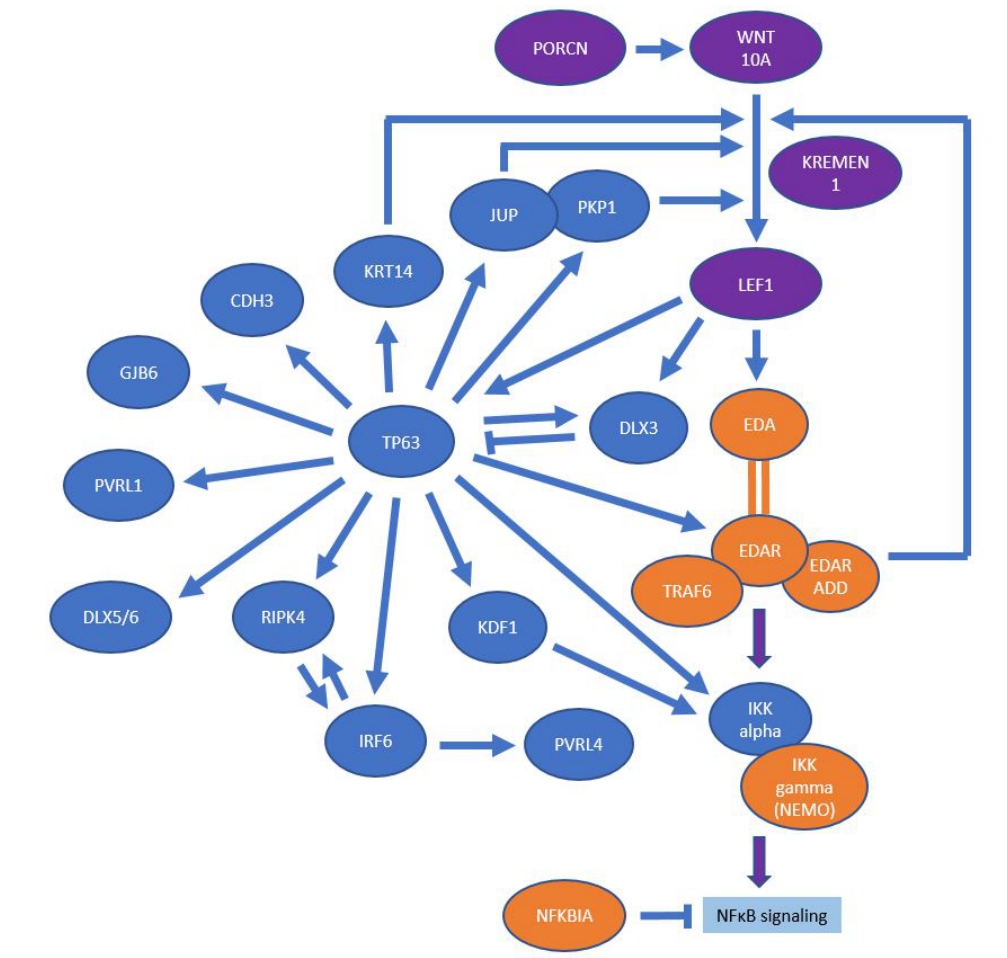
Figure 2. The multiple interactions between the EDA/NF- κ B, Wnt and p63 pathways (in orange, pur- ple, and blue, respectively). Arrows indicate stimulatory protein–protein or protein–gene regulatory interactions, bars are used for inhibitory